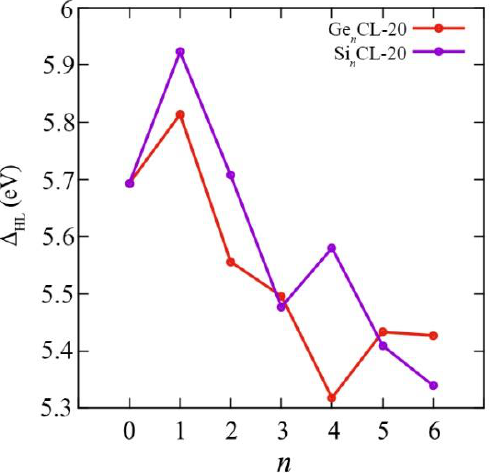
Figure 6. The HOMO–LUMO gap versus the number of Si-/Ge-atoms n in the Si n CL-20/Ge n CL-20 molecule for the most thermodynamically stable configurations obtained at the DFT/B3LYP/6- 311(d,p) level of theory.